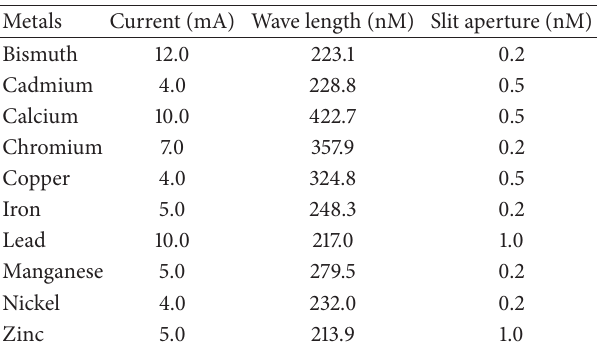
Table 3: Instrumental operating